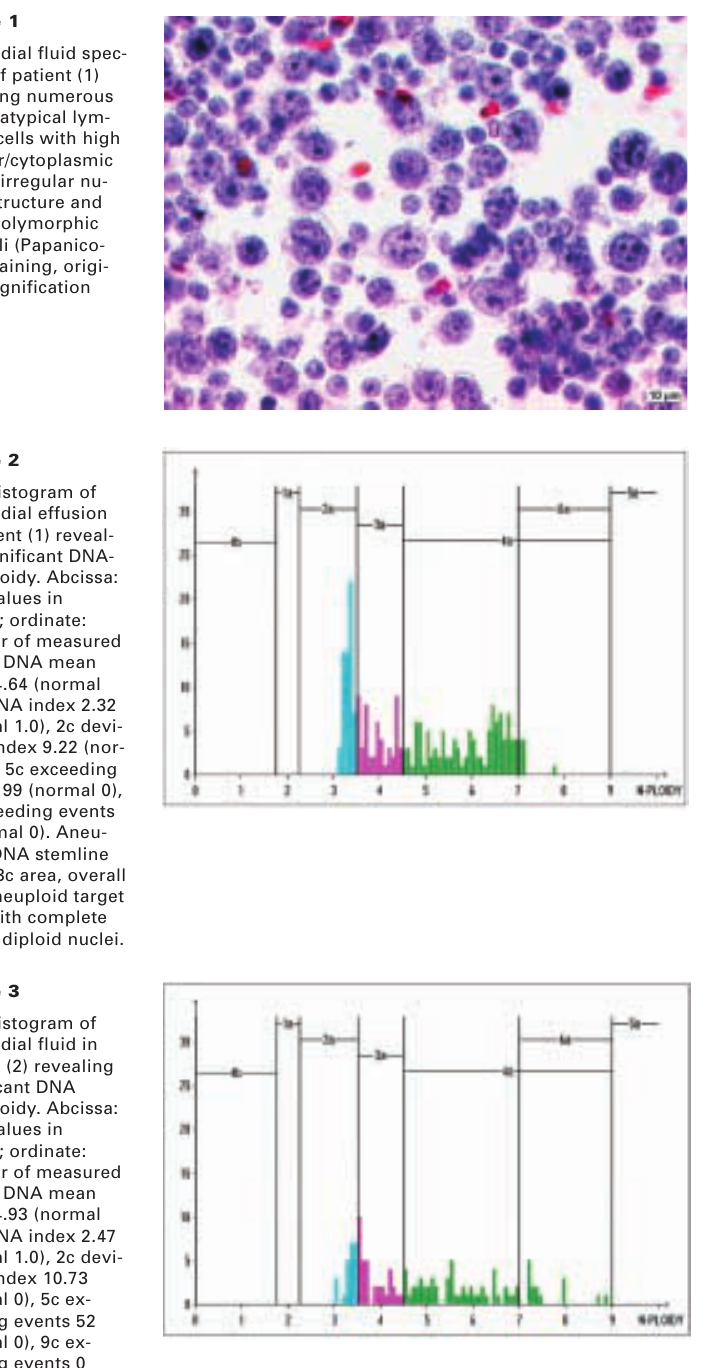
ploid DNA stemline in the 3c area, overall 60% aneuploid target cells with